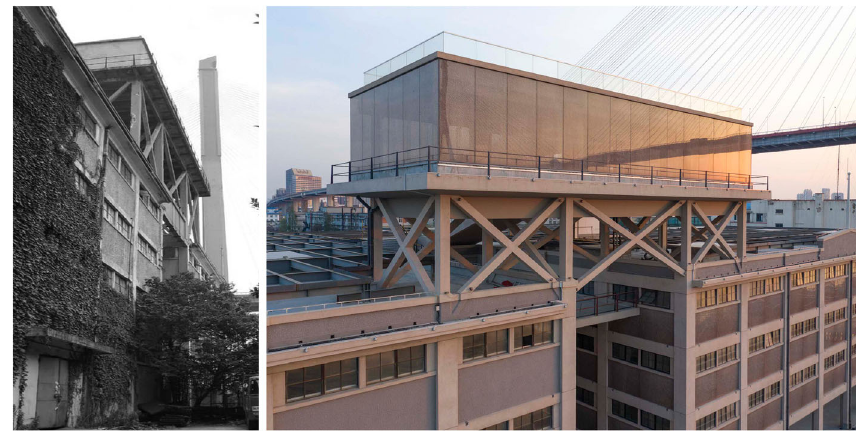
Fig. 15 Historical water tank vs. renovated observatory (Source: Fangfang